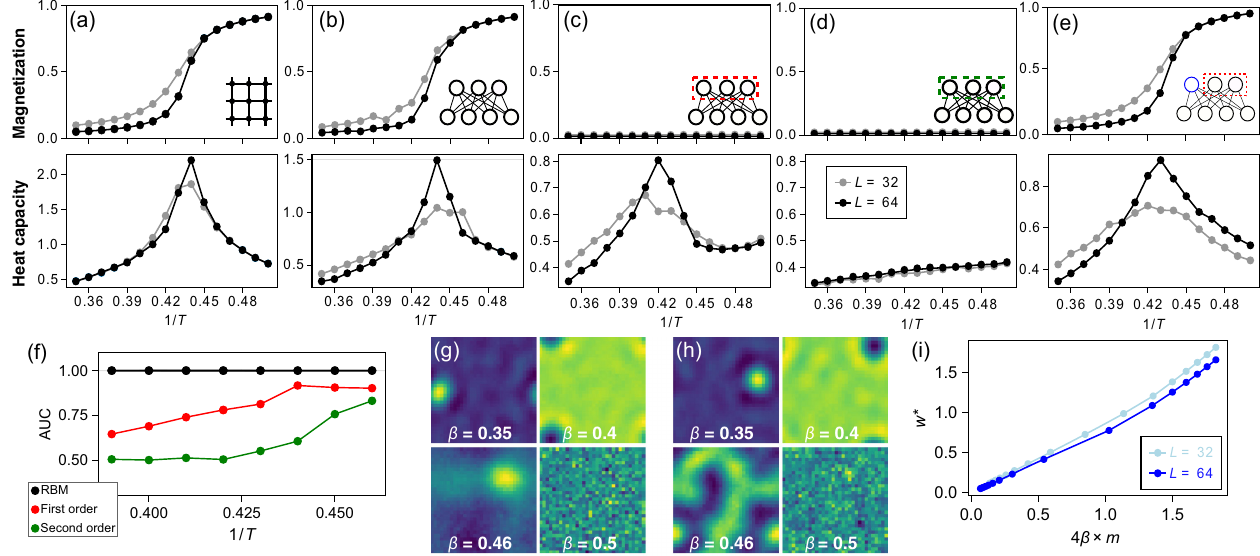
FIG. 7. Learning RBMs on two-dimensional Ising model data. (a) Magnetization and heat capacity as functions of the temperature for the samples generated by the Ising model (13). (b) Magnetization and heat capacity of samples generated by the RBM trained on the Ising data.(c)MagnetizationandheatcapacityofsamplesgeneratedbytheRBMwithconstraint(6)actingonallhiddenunits.(d)Magnetization and heat capacity of samples generated by the RBM with quadratic constraint (9) acting on all hidden units. (c) Magnetization and heat capacity of samples generated by the RBM with linear constraint (6) acting on all but one hidden unit. (f) Maximum AUC of classifiers trained to predict the sign of the sample magnetization from the RBM inputs. (g),(h) Typical weights learned by the RBM at selected temperatures ( 1 =T ¼ 0 . 35 , 0.4, 0.46, 0.5) for the unconstrained RBM and for the RBM with the first-order constraint. (i) Free weights attached to the released hidden unit compared to 4 β times the magnetization of the Ising